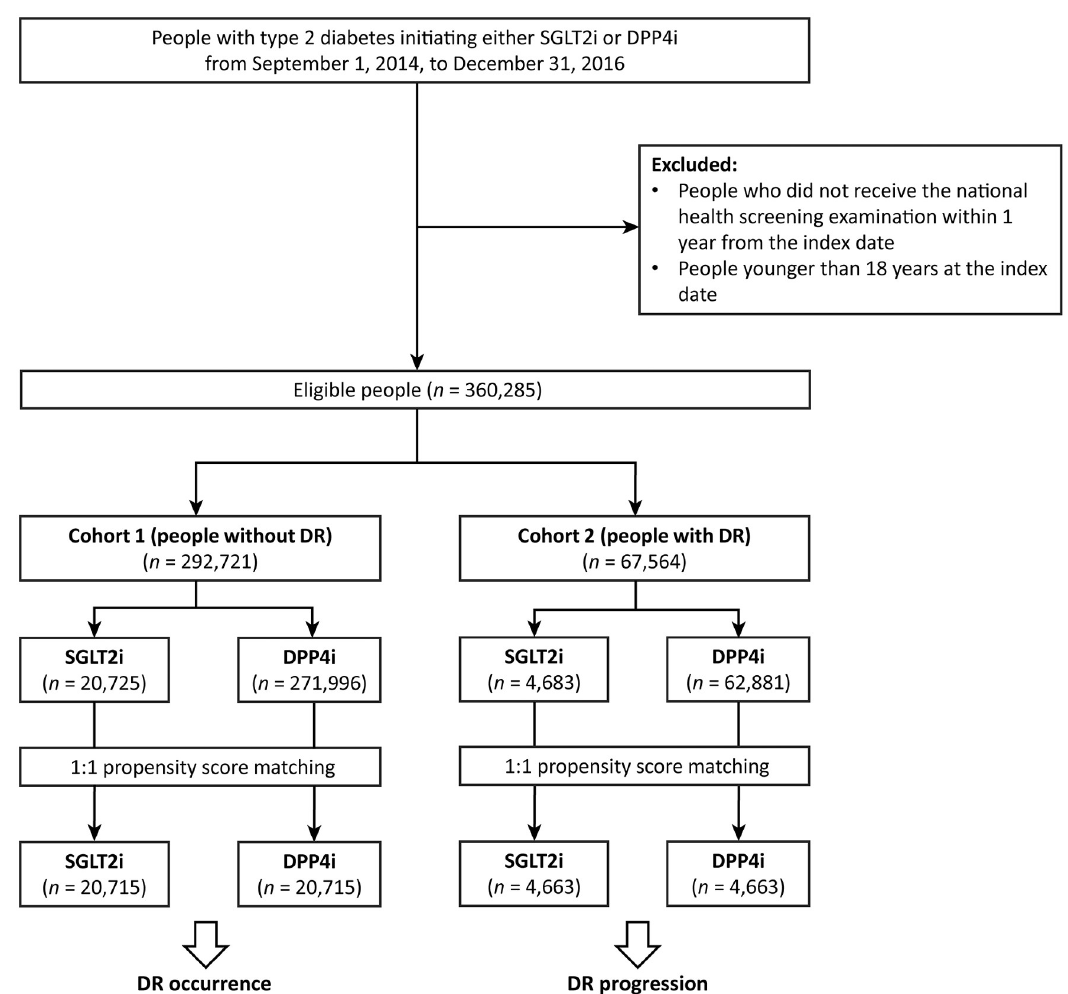
Fig 1. Flow chart of the study cohorts. DPP4i, dipeptidyl peptidase-4 inhibitor; DR, diabetic retinopathy; SGLT2i, sodium-glucose cotransporter-2